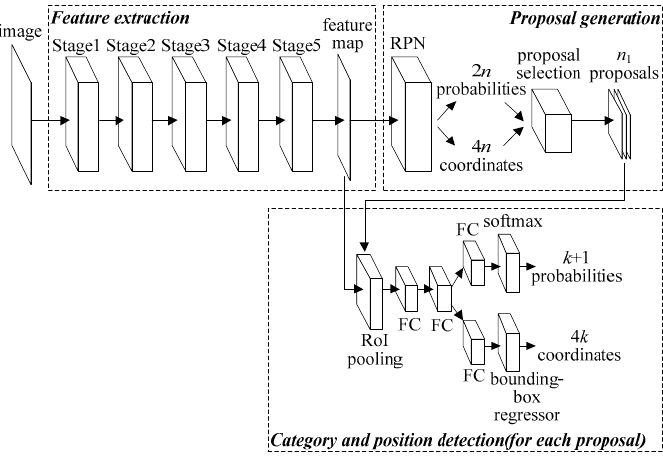
Figure 1. Faster Region ‐ based Convolutional Neural Network (Faster R ‐ CNN) architecture.